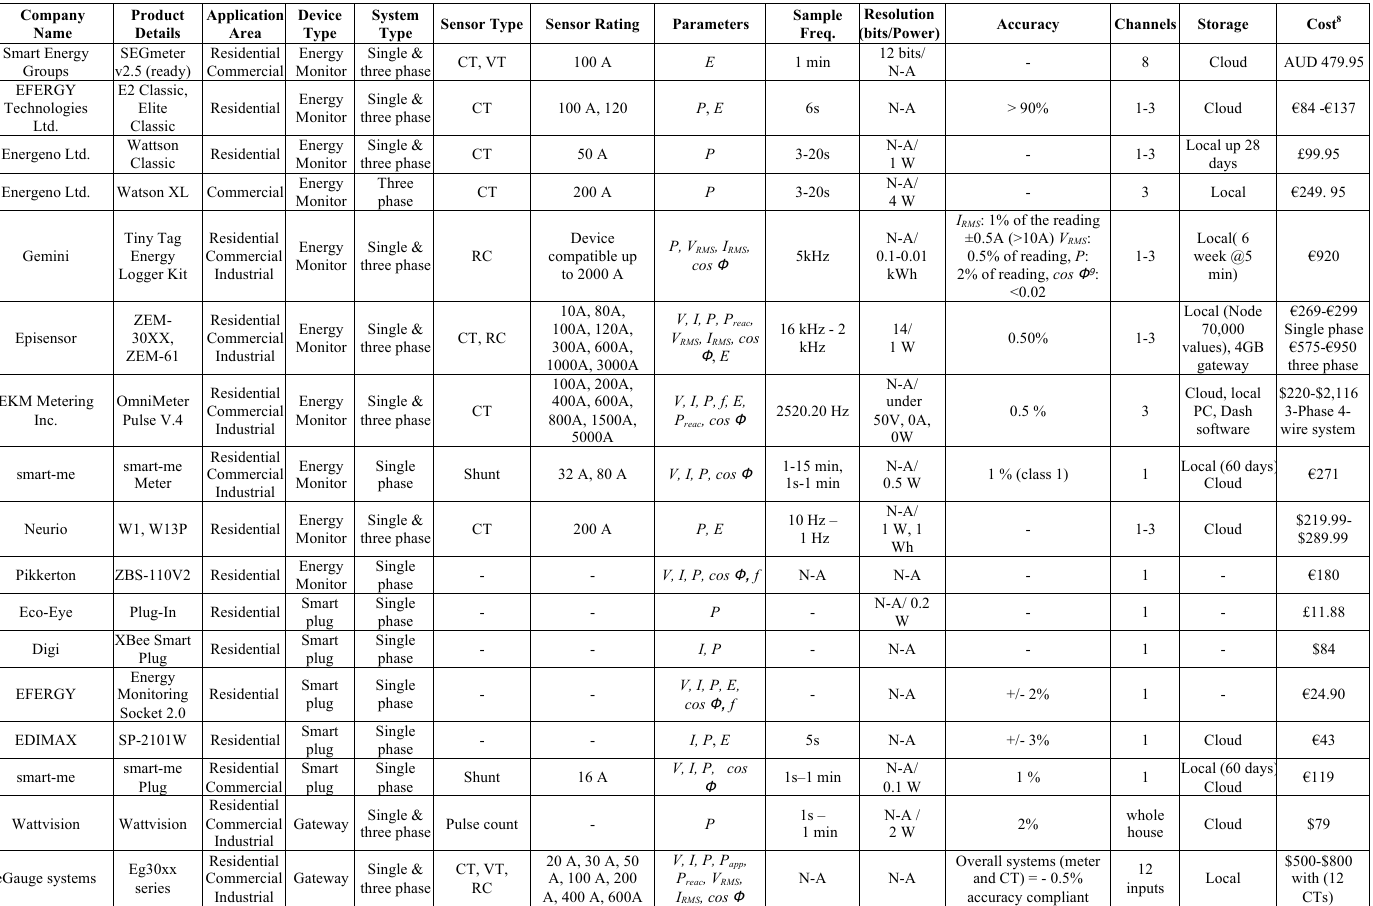
Figure A2. Technical